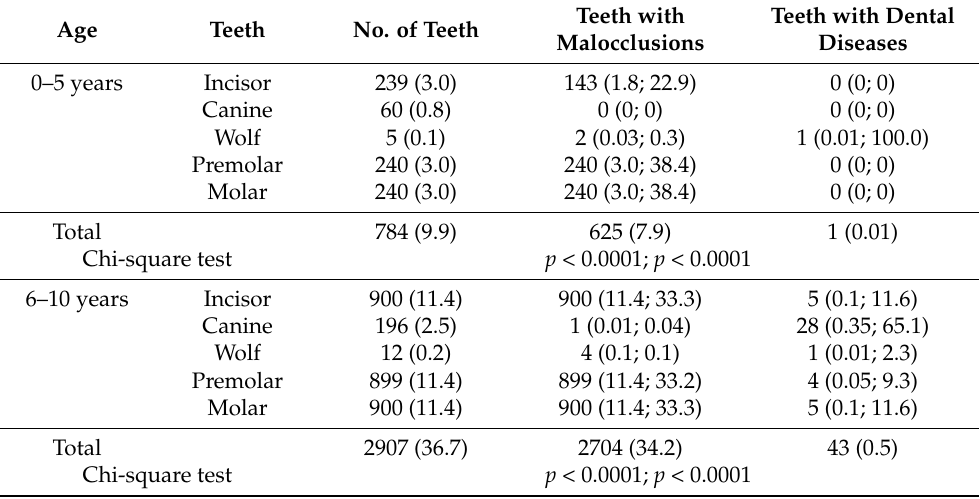
Table 2. The prevalence of malocclusions and dental diseases in 7912 examined teeth of 206 horses